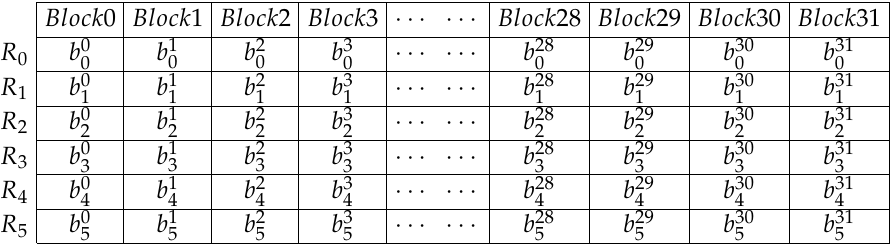
Table 2. Bit-slicing representation from using 6 32-bit registers R 0 , ..., R 5 to process 8 blocks b 0 ,..., b 7 in parallel where b i refers to the j -th bit of the i -th j